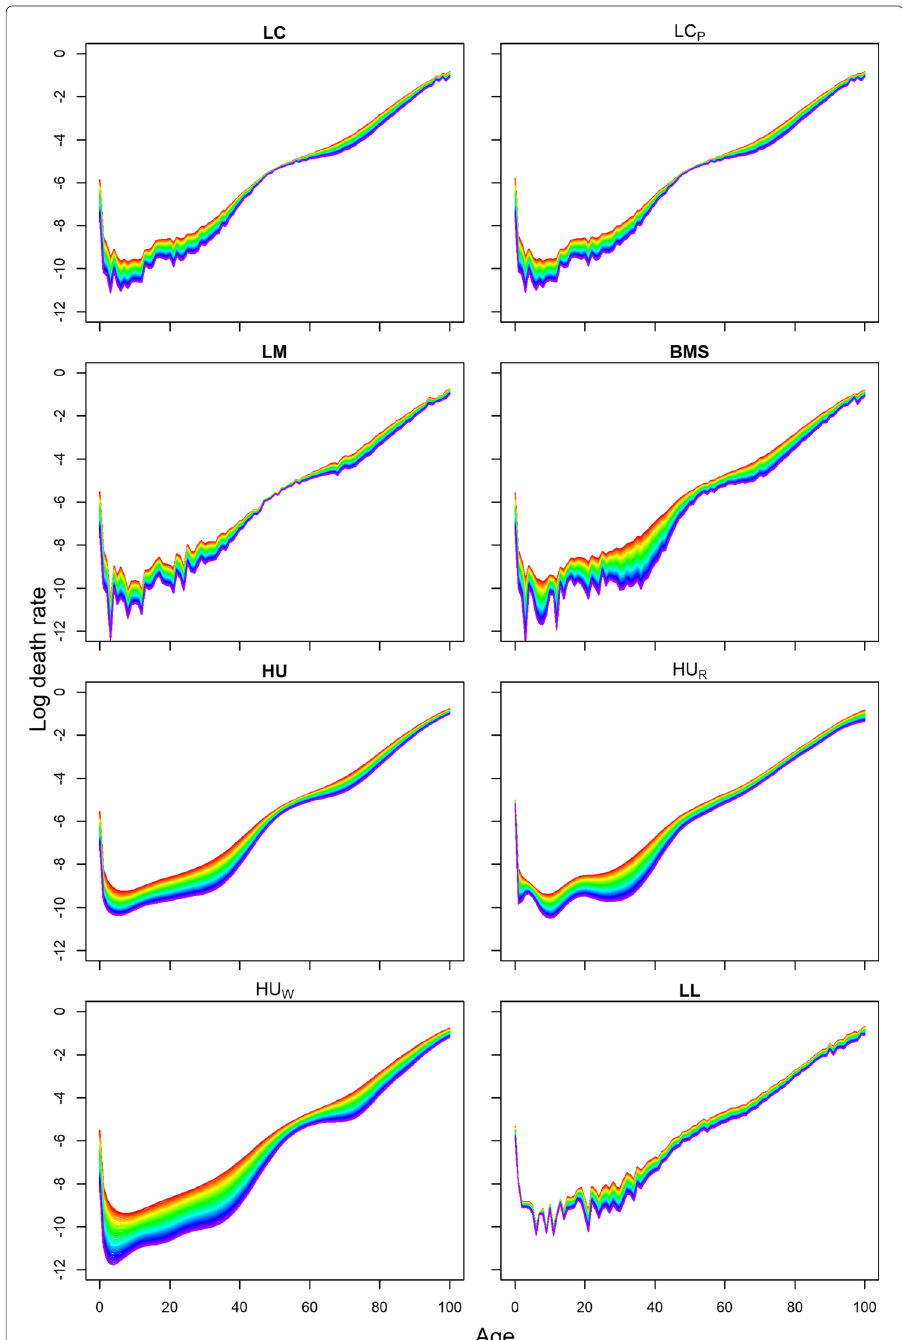
Fig. 6 Comparison of 40 years ahead forecast of log mortality rates for females of Hungary. Years are plotted using a rainbow